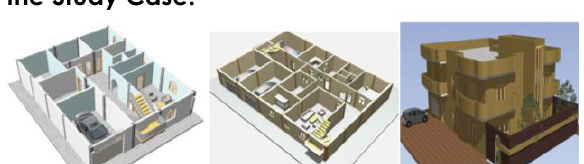
Figure 14. New House Types with New Spaces and New Materials of Construction. Saada Choukri, architect in the region of Tigharghar, Menaa.